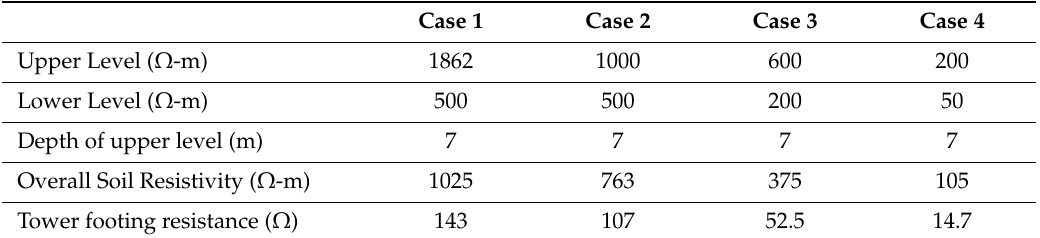
Table 1. Resistance to Tower Footing of various soil conditions.